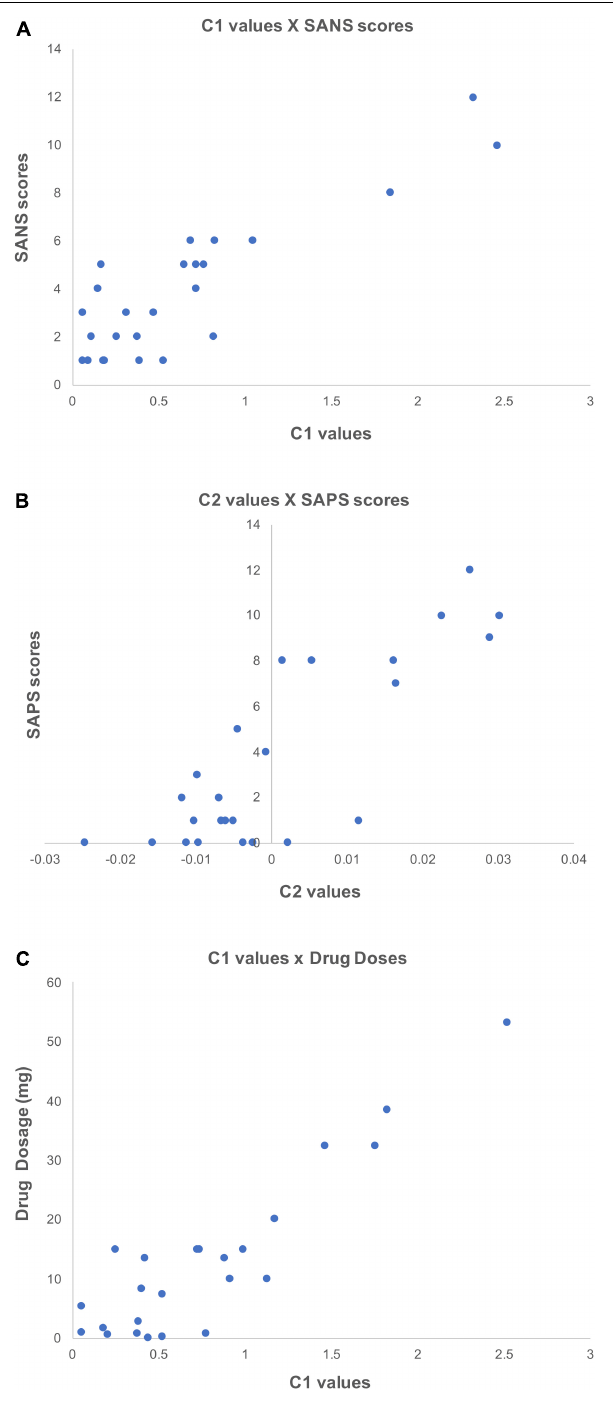
FIGURE 7 | Scatter plots showing the positive correlations between C1/C2 values and clinical information. These scatter plots depict correlations ( p < 0.05) between individually averaged C1 and C2 values and subjects’ clinical information. The averaging of C1 and C2 values was over significant nodes. (A) Shows the correlation between C1 values and patients’ SANS scores, (B) shows the correlation between C2 values and SAPS scores, and (C) shows the correlation between C1 values and patients medication dosage (olanzapine equivalent in